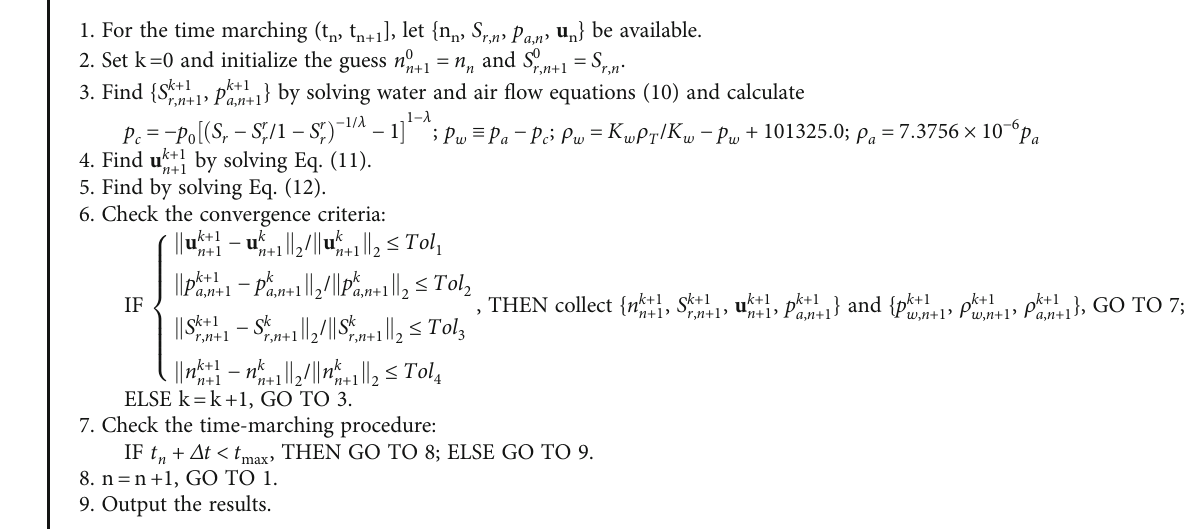
Algorithm 1: The iteration procedure for solving the displacement-saturation-pressure-porosity